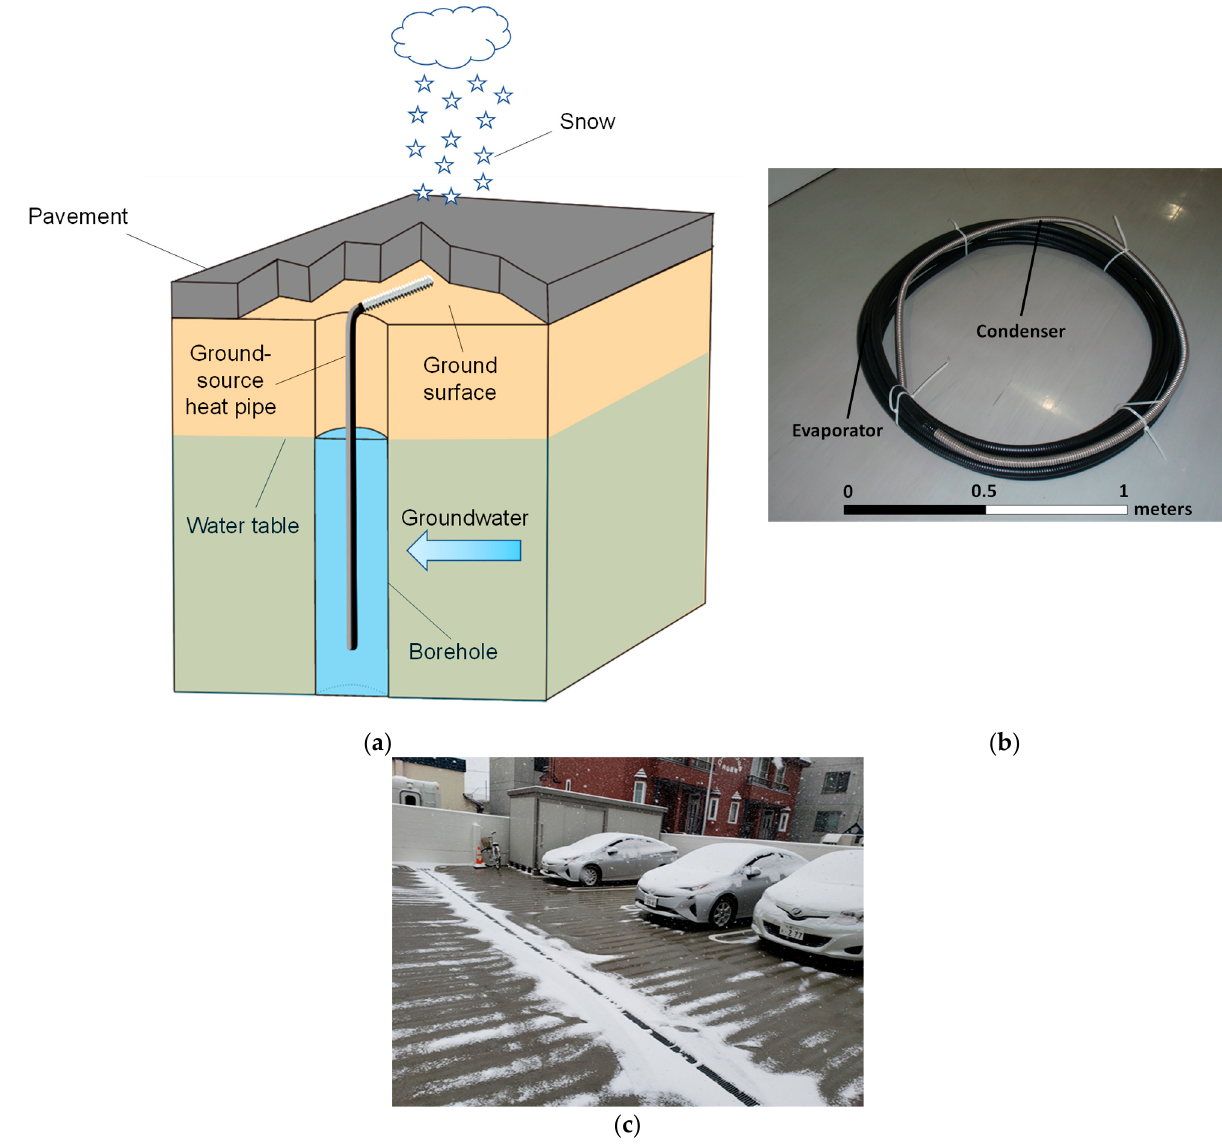
Figure 1. A schematic of ground-source heat pipe system for snow melting ( a ) with two example photos: ( b ) ground-source heat pipe for this study and ( c ) snow melting on a parking lot, Sapporo, Japan.